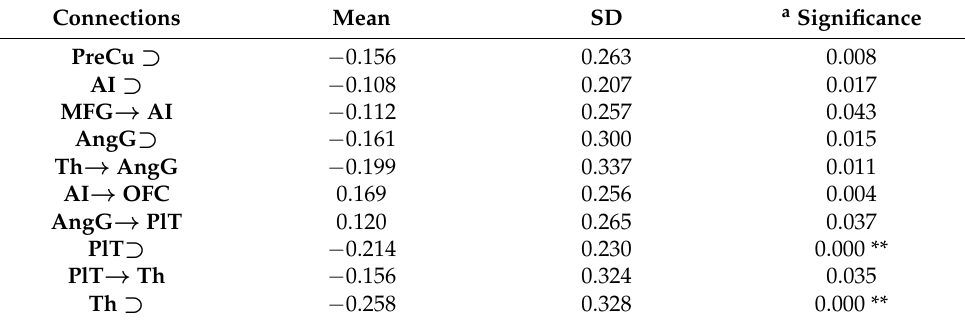
Table 4. Connections significantly different from zero in the schizophrenia group.